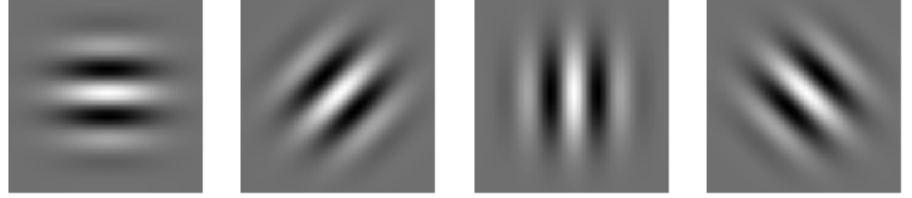
Figure 5. Parameters of the Gabor filter set: f = 3.0, size = 21, 4 rotations: θ 0 = 0 ◦ , θ 1 = 45 ◦ , θ 2 = 90 ◦ , θ 3 = 135 ◦ and γ = 10, η =